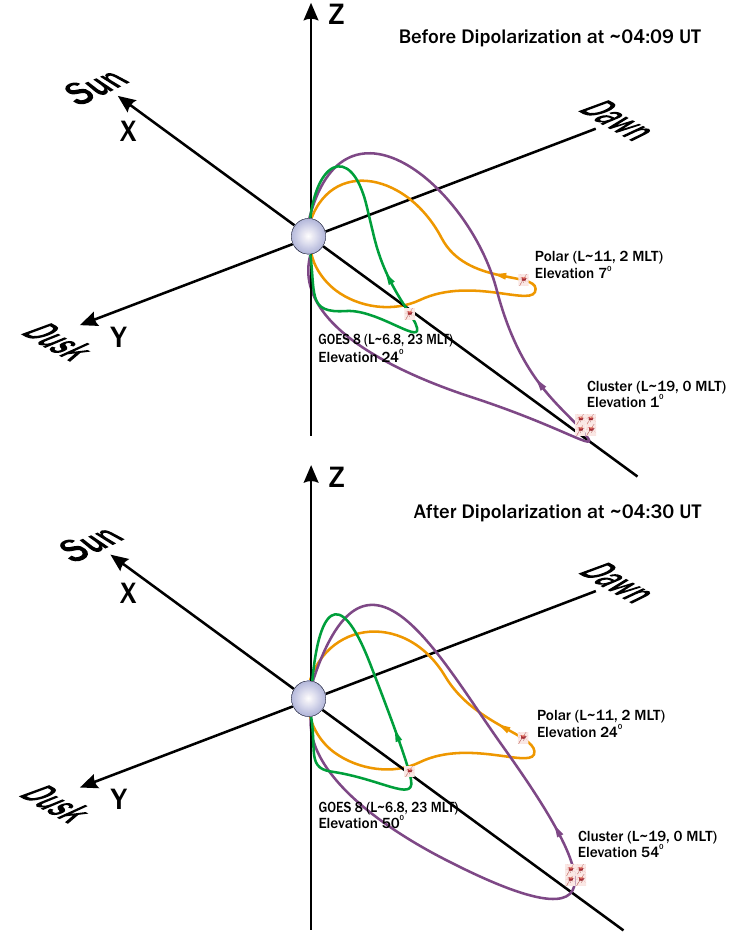
Fig. 10. Global magnetic field reconfiguration during the event. Also shown are the spacecraft positions and the magnetic field elevation